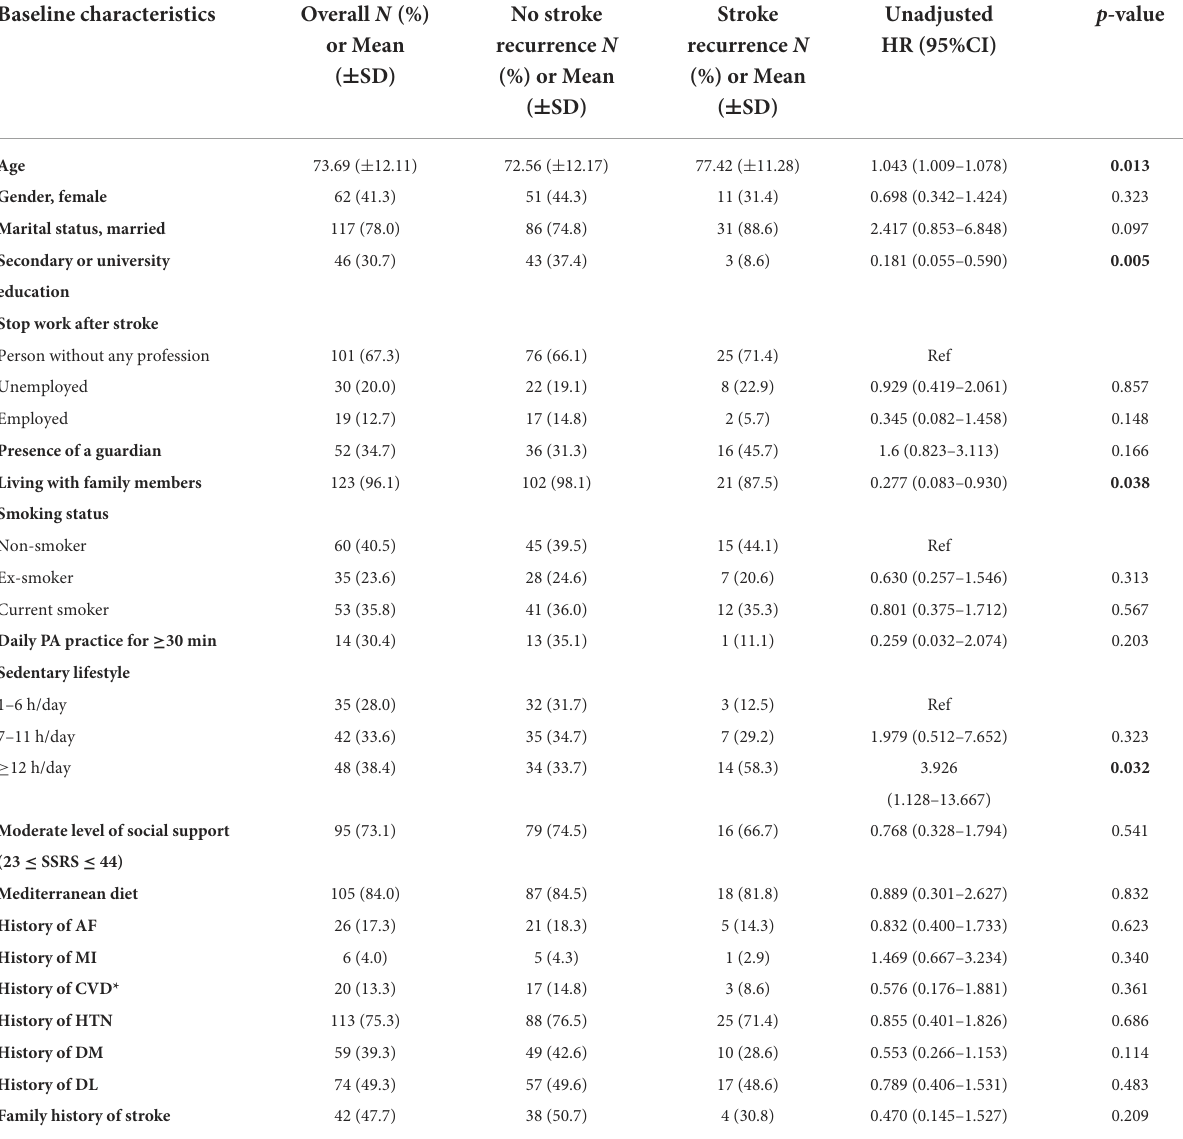
TABLE 3 The association of baseline characteristics with 1-year stroke recurrence using cox proportional hazard regression univariate analysis. Baseline